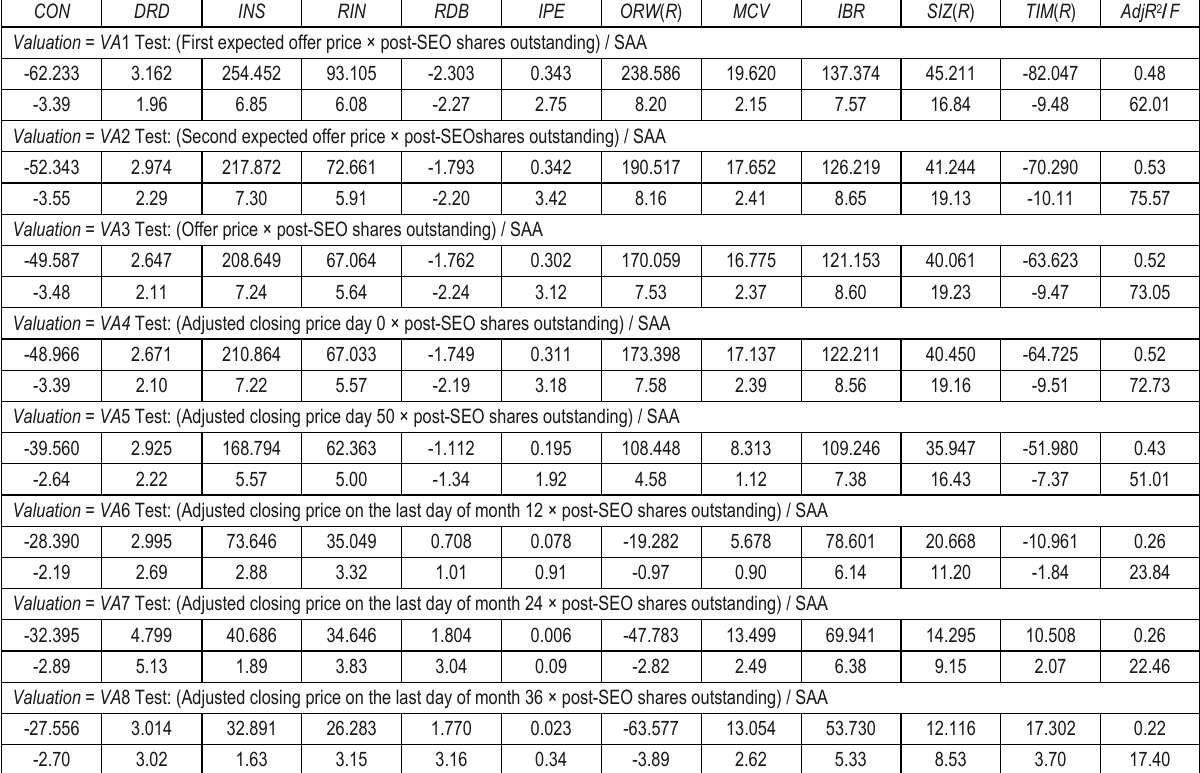
Table 3. OLS Regression results for valuation